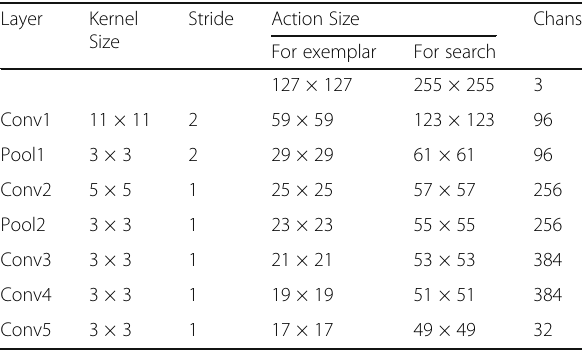
Table 1 Architecture of the Baseline-conv5 model Layer